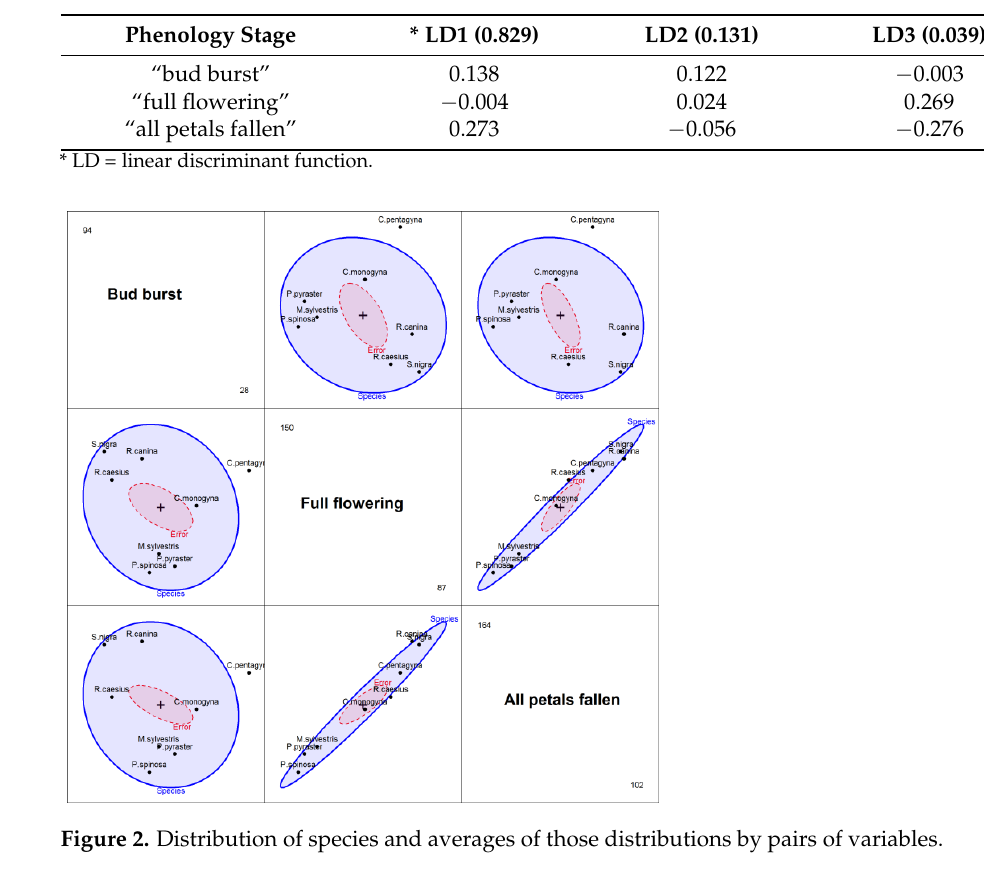
Table 2. Structural coefficients (correlation) between each variable and two canonical functions.